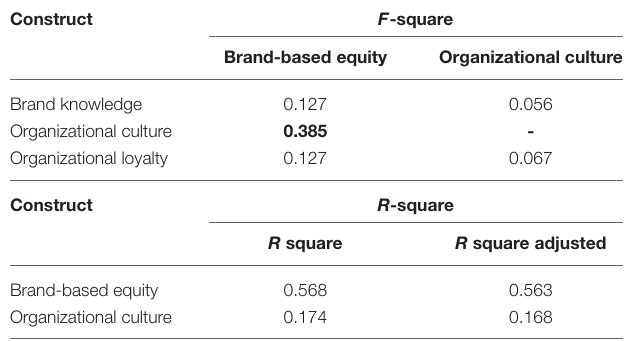
TABLE 7 | Hypotheses